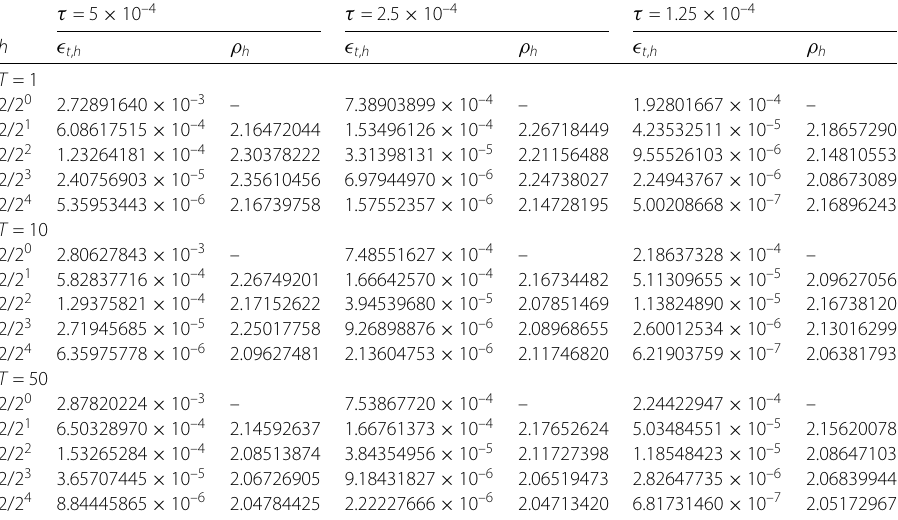
Table 5 Table of absolute errors in the maximum norm and spatial rates of convergence for various values of the parameters τ and h . We used f ( u ) = u (1 – u ), and the exact solution (58) of model (46). We employed also Ω = (–200,200) and various values of T τ = 5 × 10 –4 τ = 2.5 × 10 –4 τ = 1.25 × 10 –4 h (cid:22) t , h ρ h (cid:22) t , h ρ h (cid:22) t , h ρ